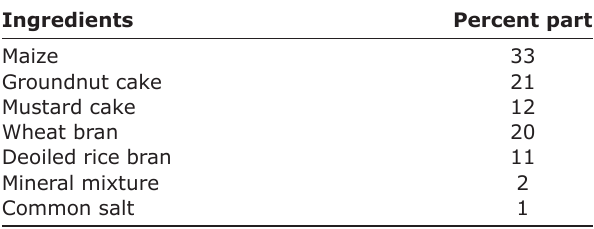
Table-1: Physical composition of concentrate mixture.